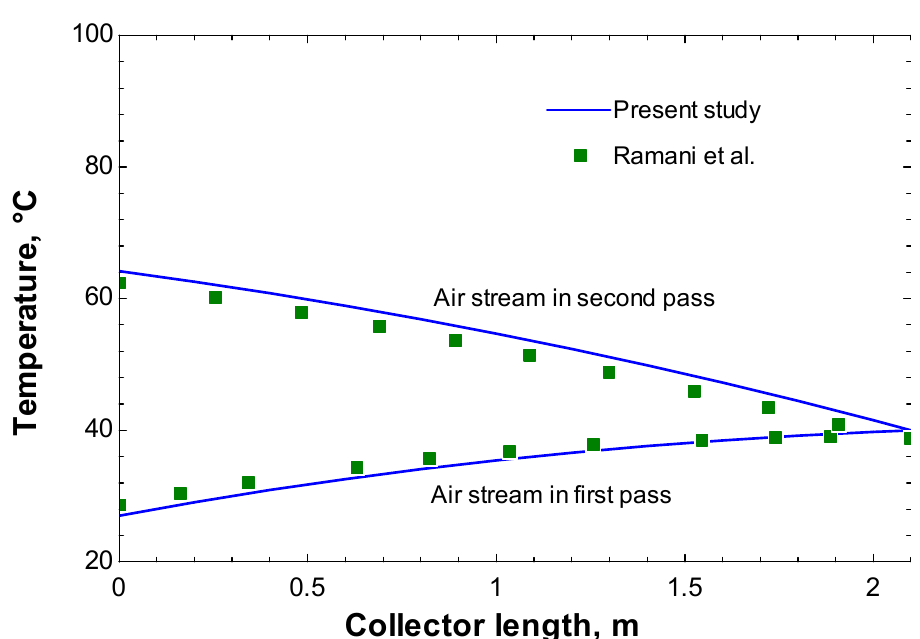
Figure 2. Validation of local air temperatures with the published data [16].